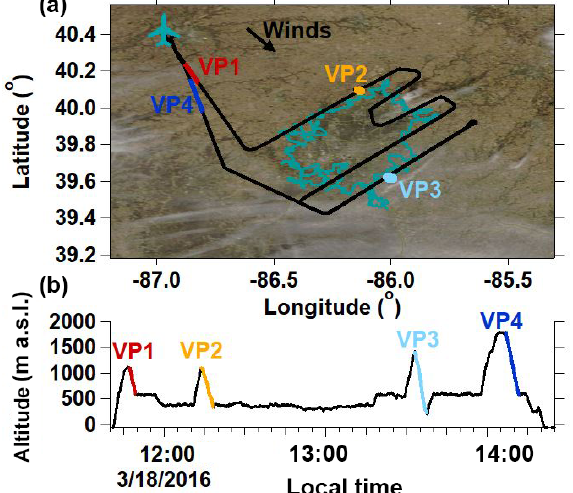
Figure 10. (a) DBL flight path overlaying the study site’s cloud cover (https://worldview.earthdata.nasa.gov/, last access: 5 Febru- ary 2018) captured at approximately 12:30LT. The teal outline in- dicates the Indianapolis city boundaries. The West Lafayette, IN, Purdue airport is indicated by the airplane marker. (b) DBL case study altitude time series. Colored segments indicate vertical pro- file (VP)